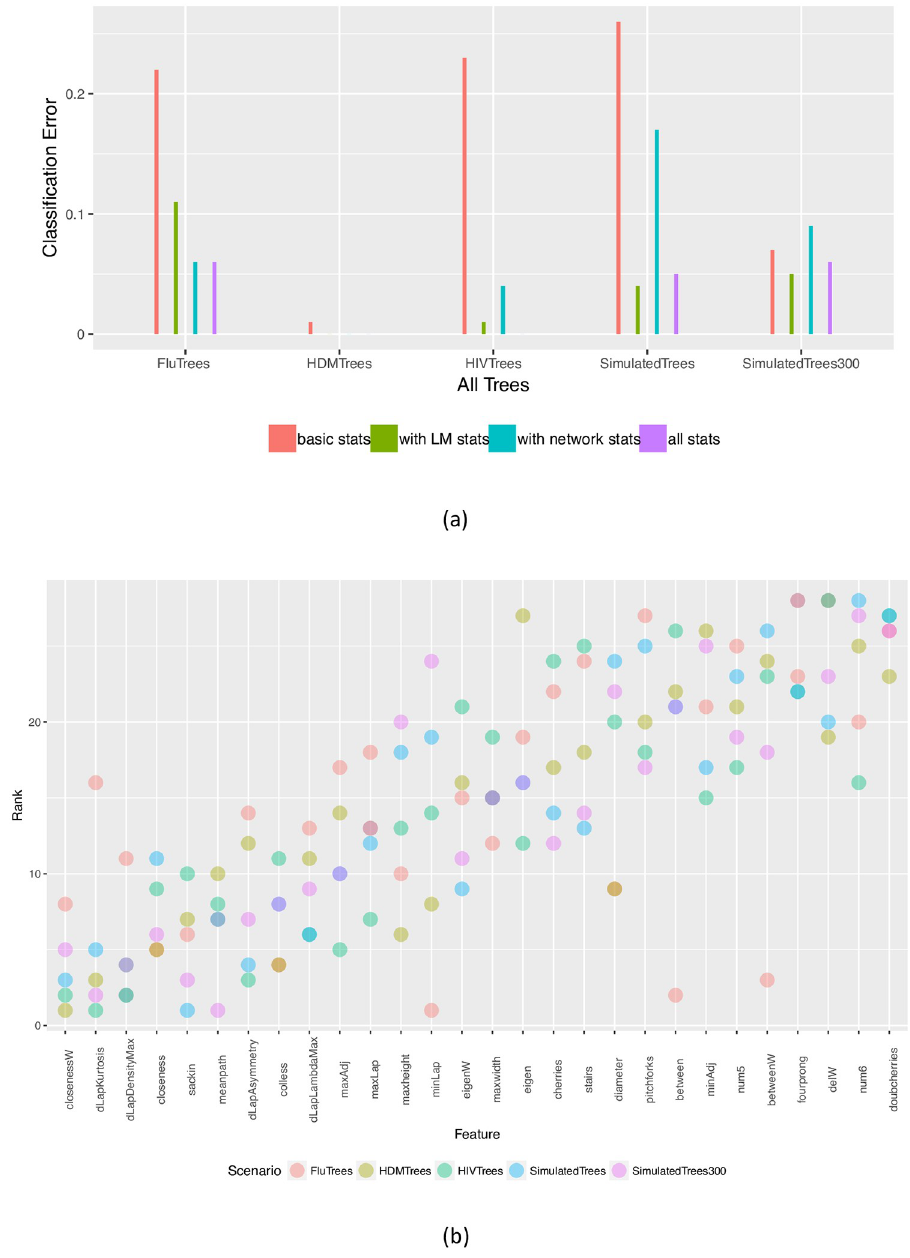
Fig 6. (a) Accuracy of classification with and without network science features, as well as with and without the distance Laplacian spectral features. (b) Feature importance in multi-class classification across all scenarios, ordered by the median. Here the importance for each feature is computed based on the mean decrease in node impurity (we use the varImp function in R , which uses the Gini index as an impurity measure). Each point is the rank of the corresponding feature in one of the classification tasks. Low ranks correspond to the most important features (i.e. the top-ranked feature has rank 1, and so on).